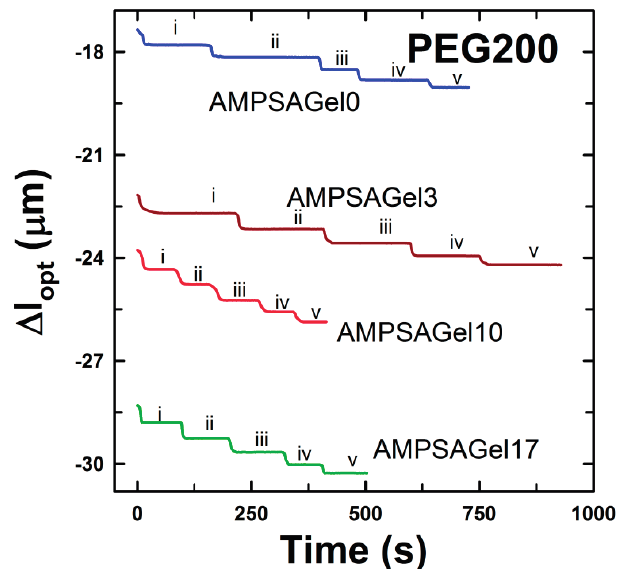
Figure 5. Deswelling kinetics of AMPSA -co- AAm hydrogels. The AMPSA -co- AAM hydrogels consisted of 10 wt % AAM, 3 mol % Bis (relative to AAm) and 3 mol % AMPSA (relative to AAm) and 0 (AMPSAGel0, l opt = 50.3 µm), 3 wt %